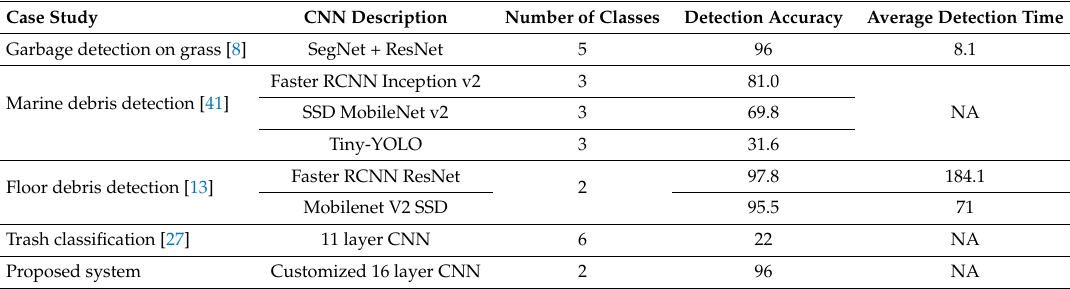
Table 4. CNN Case Study.